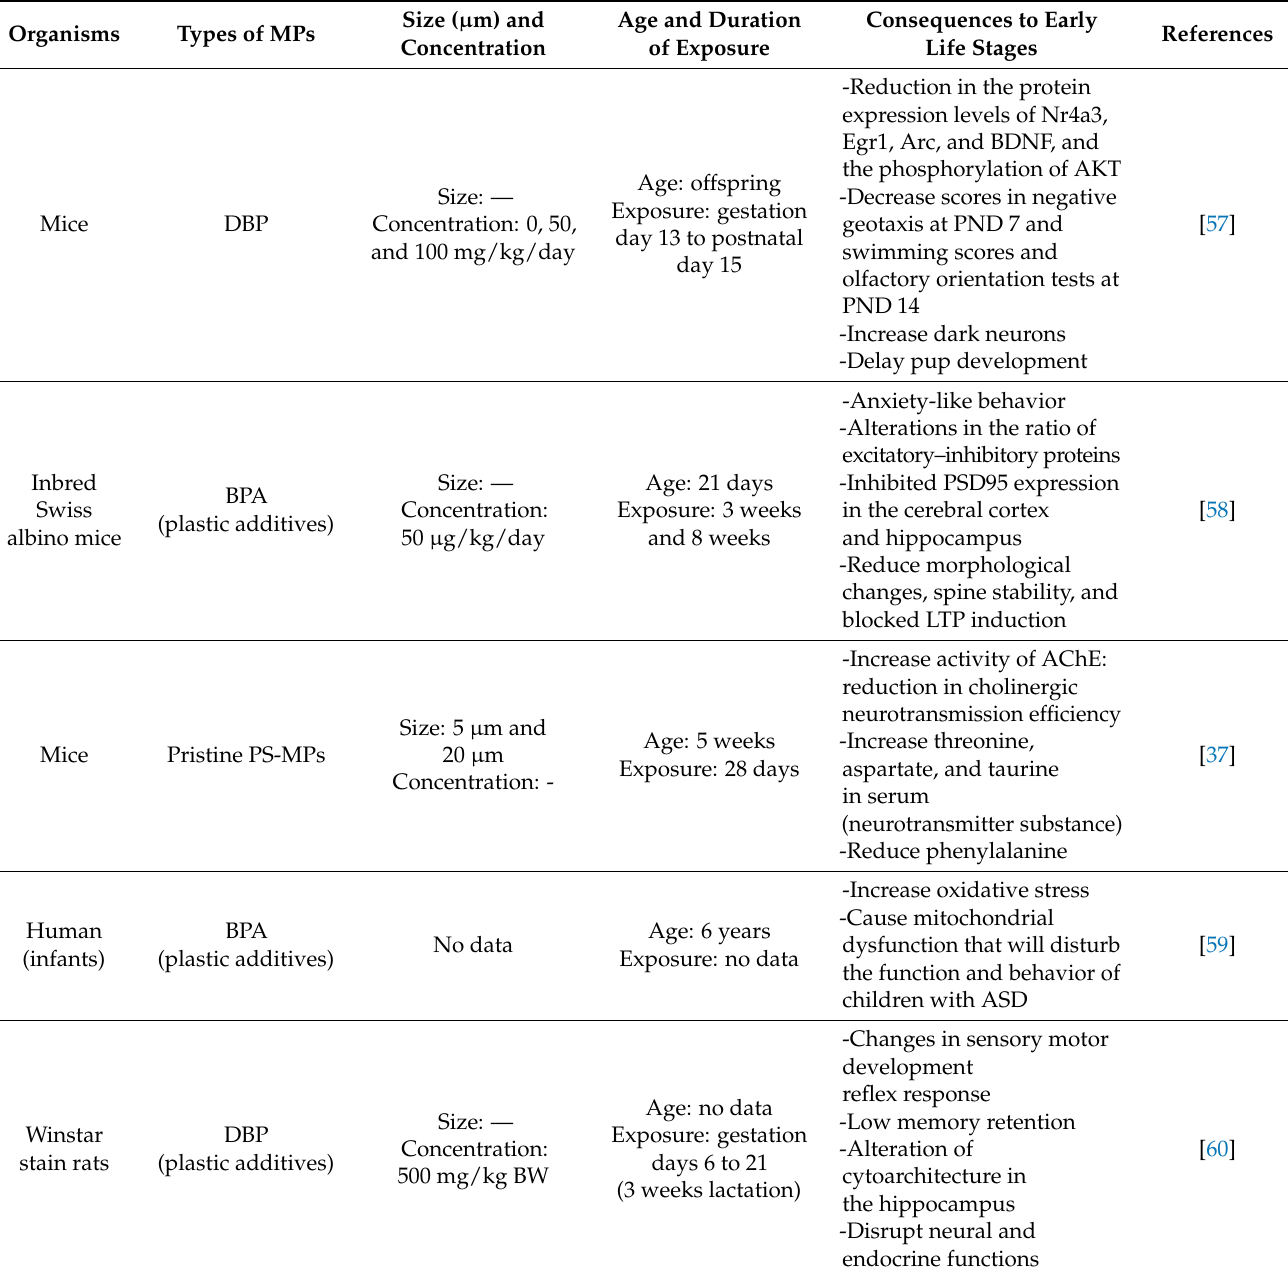
Table 3. Summary of the effects of MPs exposure on the central nervous system during the early developmental